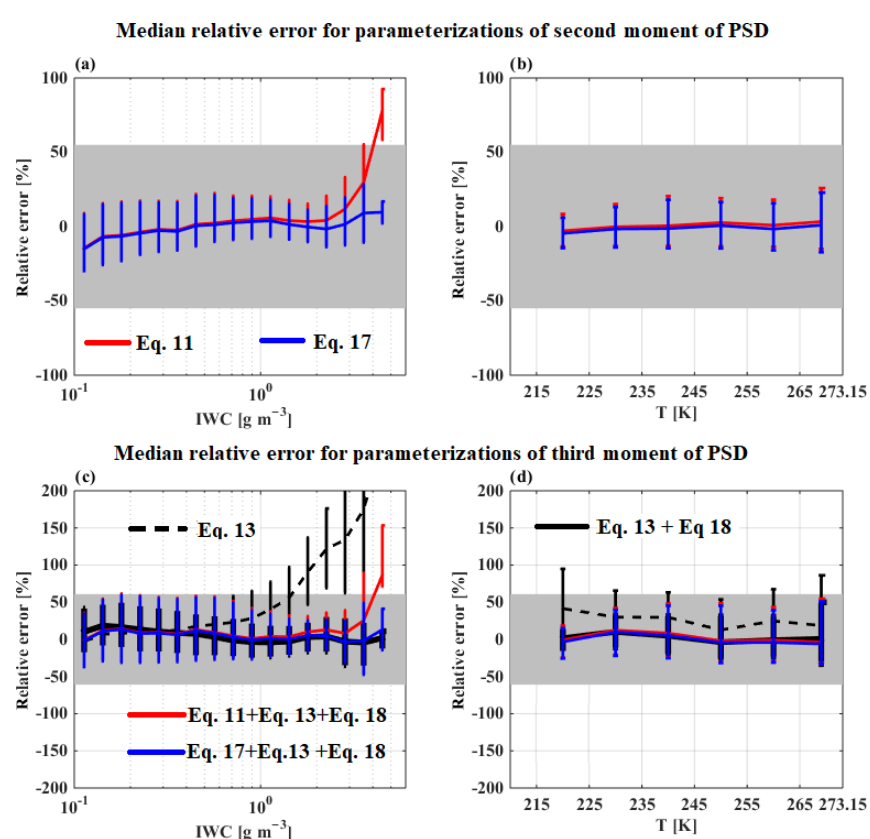
Figure 27. Relative error of parameterized M 2 and M 3 for the merged dataset as a function of IWC in (a) and (c) and as a function of T in (b) and (d) . The solid lines give the median relative error and the whiskers denote the 25th and 75th percentiles of relative error. The grey band shows measurement uncertainties for M 2 (55%; a and b ) and M 3 (61%; c and d ),